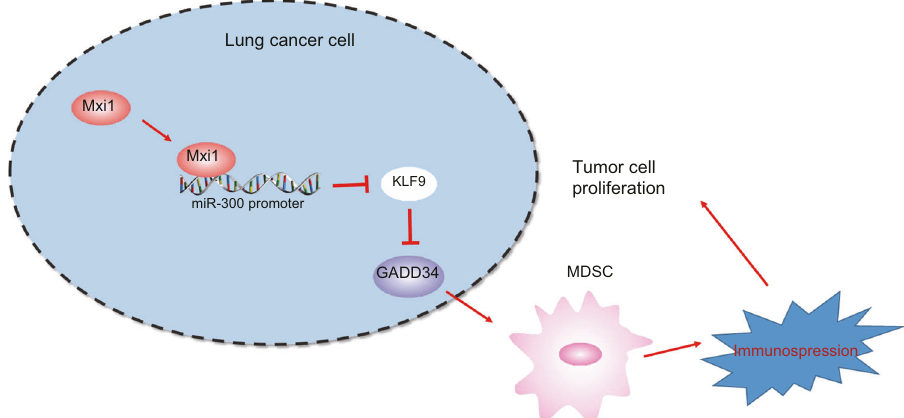
Fig. 8 Mechanistic diagram. Mxi1 suppresses miR-300 expression at transcription level, upregulates the expression of KLF9 and reduces GADD34 expression, thus inhibiting immunosuppression of MDSCs and preventing lung tumor